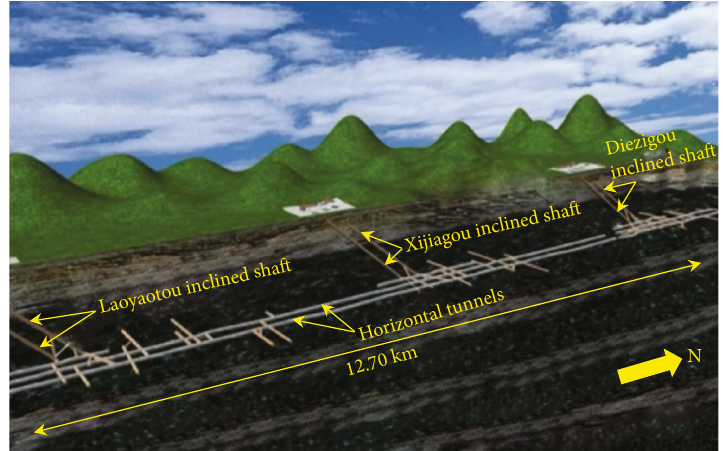
Figure 3: Distribution of tunnels at the Wangjialing coal mine.